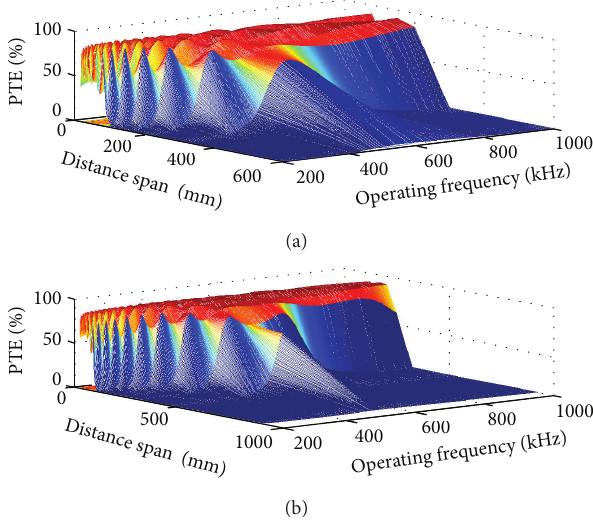
Figure 9: PTE versus operating frequency and distance span. (a) DCR configuration scenario A. (b) DCR configuration scenario